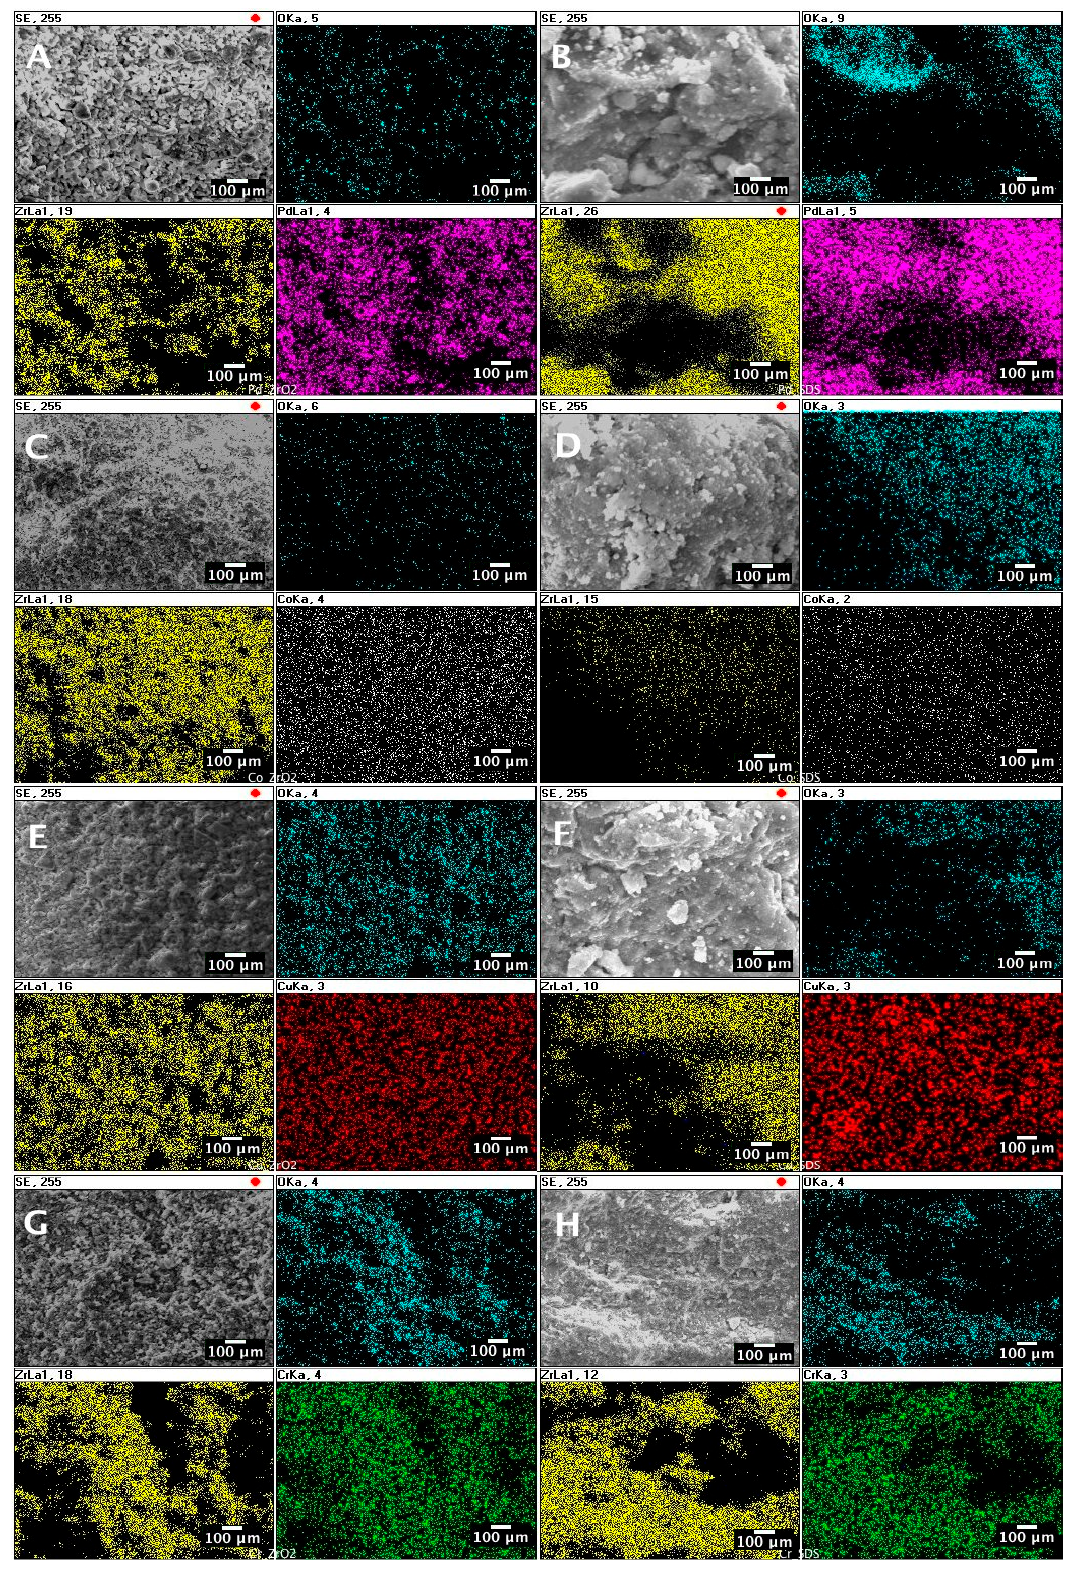
Figure 3. SEM/EDS mapping of prepared catalyst samples: ( A ) Pd/ZrO 2 ; ( B ) Pd/ZrO 2 /SDS; ( C ) Co/ZrO 2 ; ( D ) Co/ZrO 2 /SDS; ( E ) Cu/ZrO 2 ; ( F ) Cu/ZrO 2 /SDS; ( G ) Cr/ZrO 2 ; ( H ) Cr/ZrO 2 /SDS; Correspondence of colours and elements: O: cyan, Zr: yellow, Pd: magenta, Co: white, Cu: red, Cr: green.